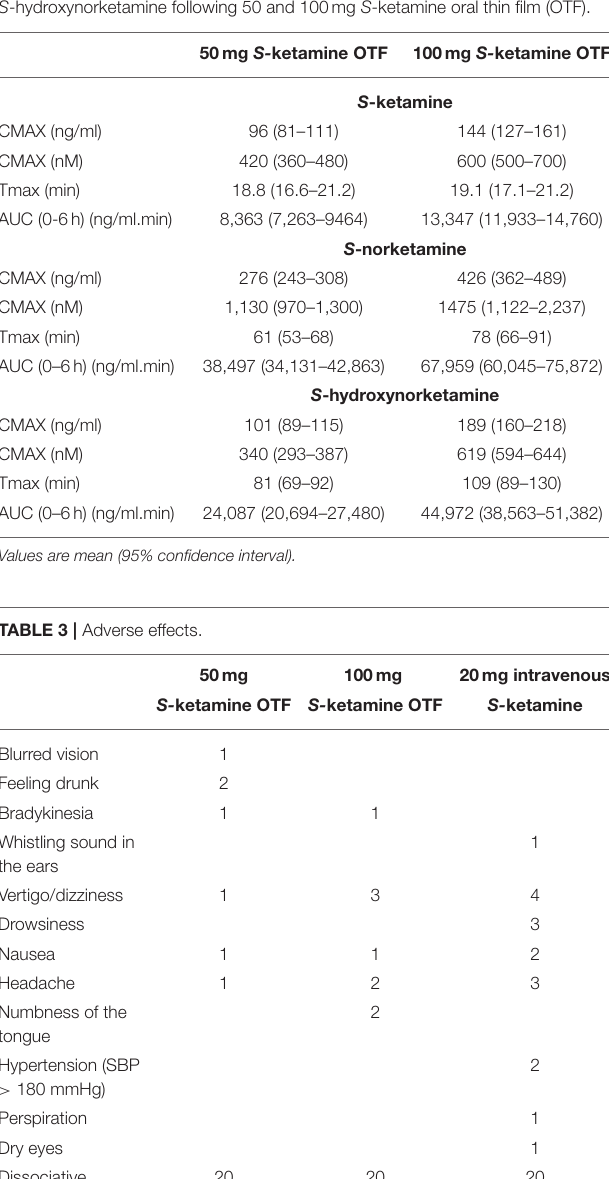
TABLE 2 | Peak concentration (CMAX), time of CMAX, and area-under-the time-concentration curve (AUC) of S -ketamine, S -norketamine and S -hydroxynorketamine following 50 and 100mg S- ketamine oral thin film (OTF).